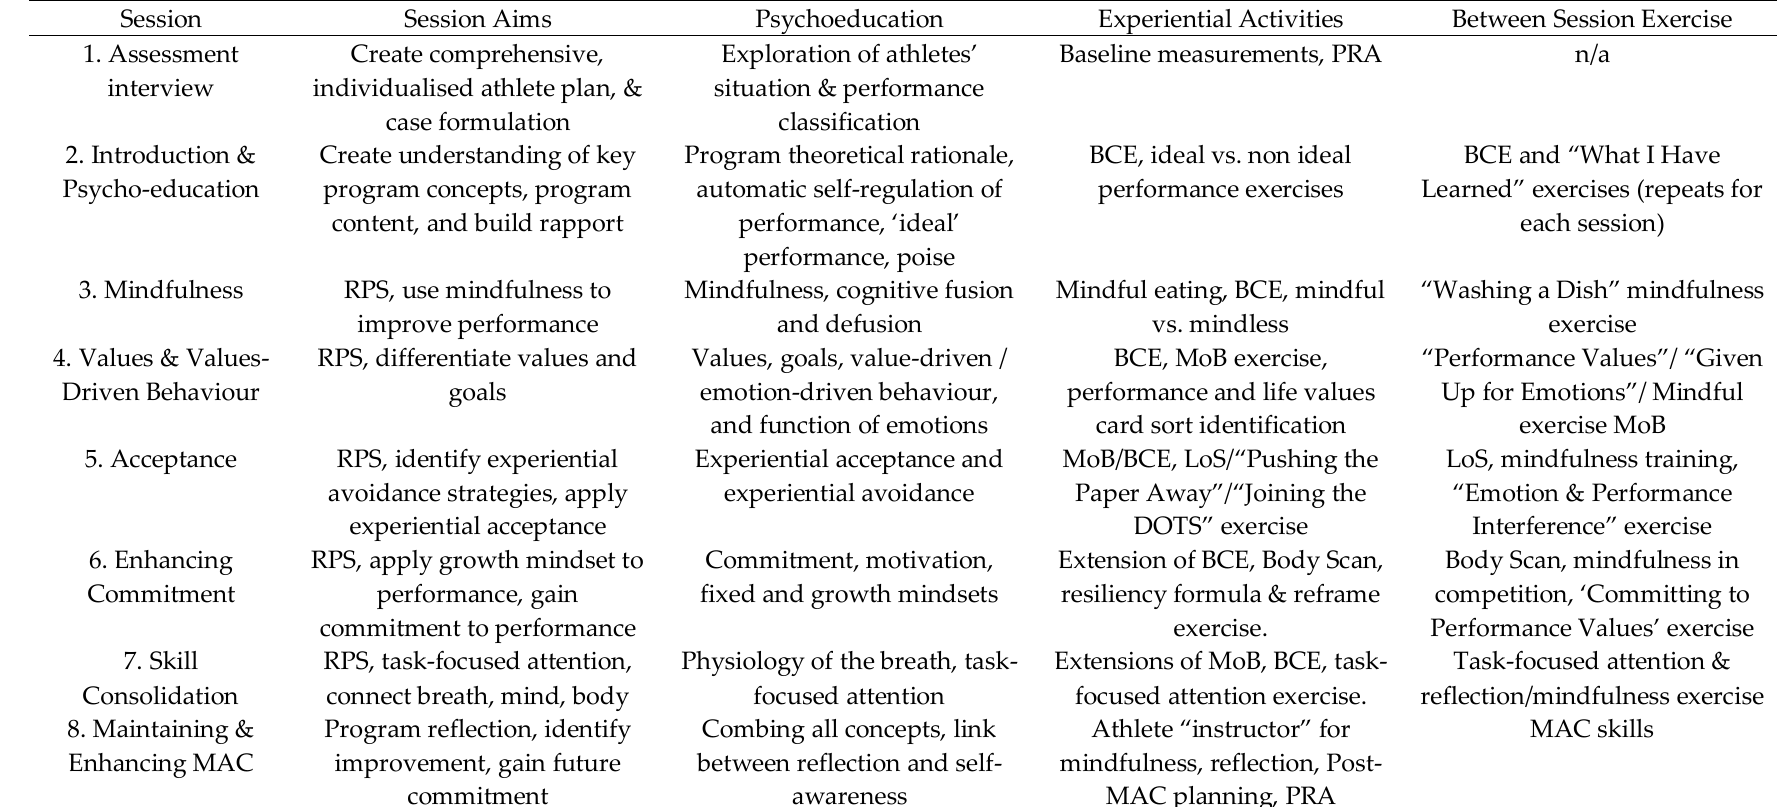
Table 1: Outline of Individual Sessions